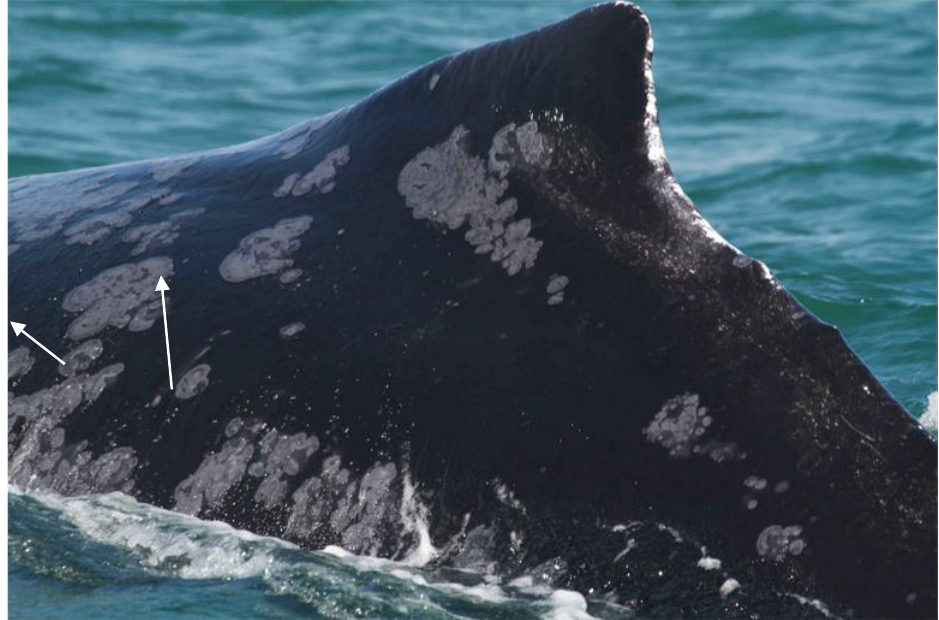
Figure 4. Numerous, small to large tattoo-like skin lesions (arrows) on the back and flank of a hump- back whale ( Megaptera novaeangliae ) from Oman (Photo: copyright Environmental Society of